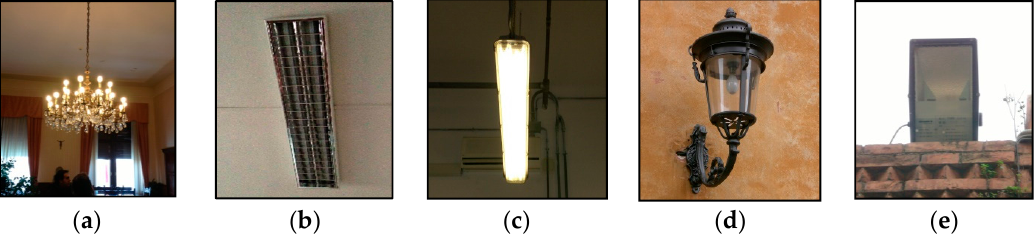
Figure 5. Relief of the lighting system, examples of: ( a ) historical luminaires; ( b ) luminaires for offices and for ( c ) archives; ( d ) historical lanterns and ( e ) perimetral luminaires.